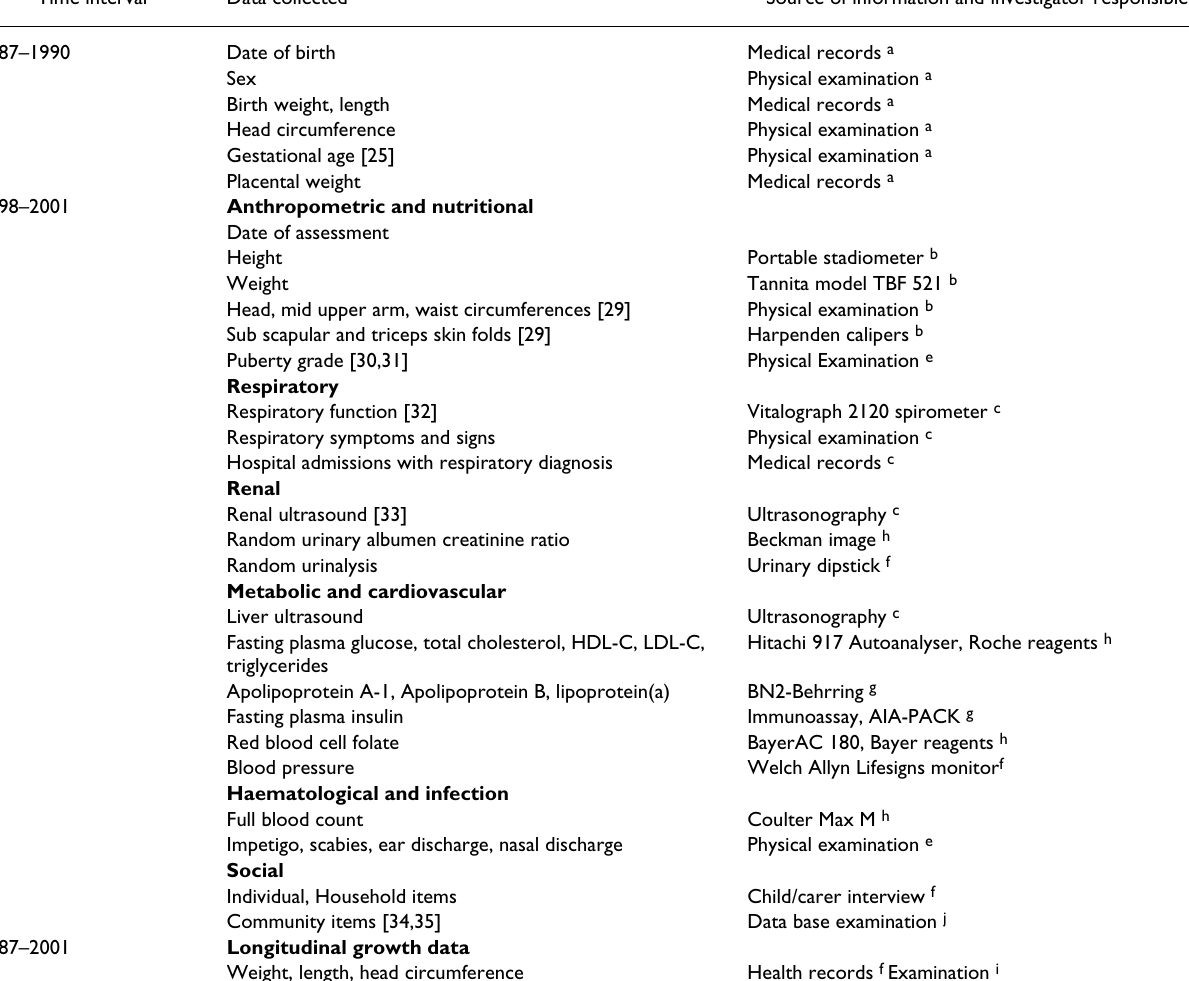
Table 2: Data collected and source of information and investigators involved for phases 1 and 2. Aboriginal birth cohort study Time